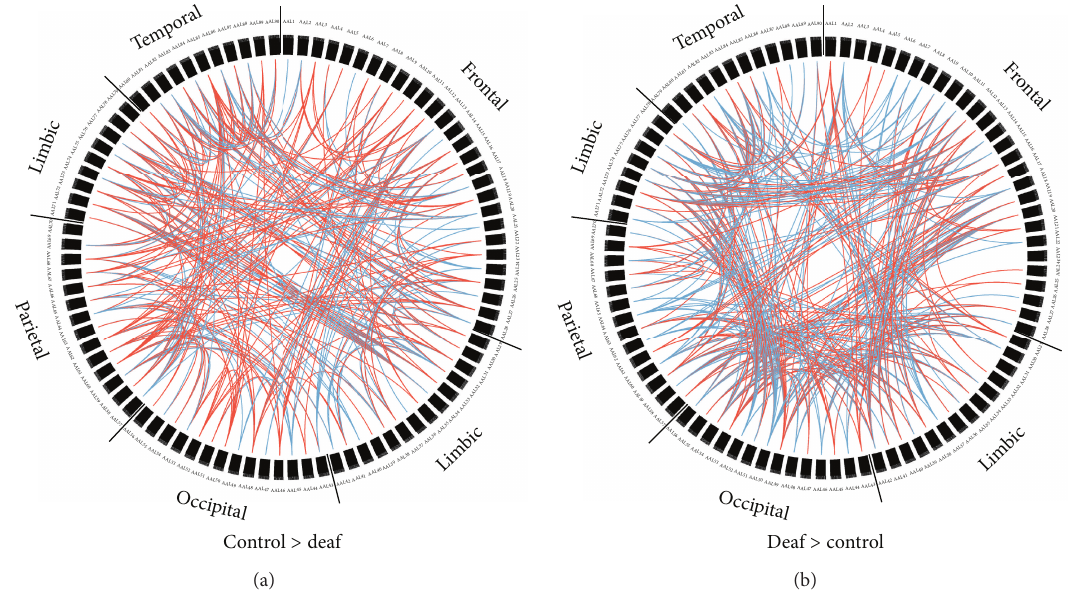
Figure 2: Group differences of brain functional connectivity between prelingually deaf adolescents and normal controls (uncorrected, 𝑝 < 0.05 ). (a) represents stronger functional connectivity in normal controls, while (b) shows stronger connectivity in prelingually deaf subjects. The red color indicates unilateral connections, and the blue color indicates bilateral